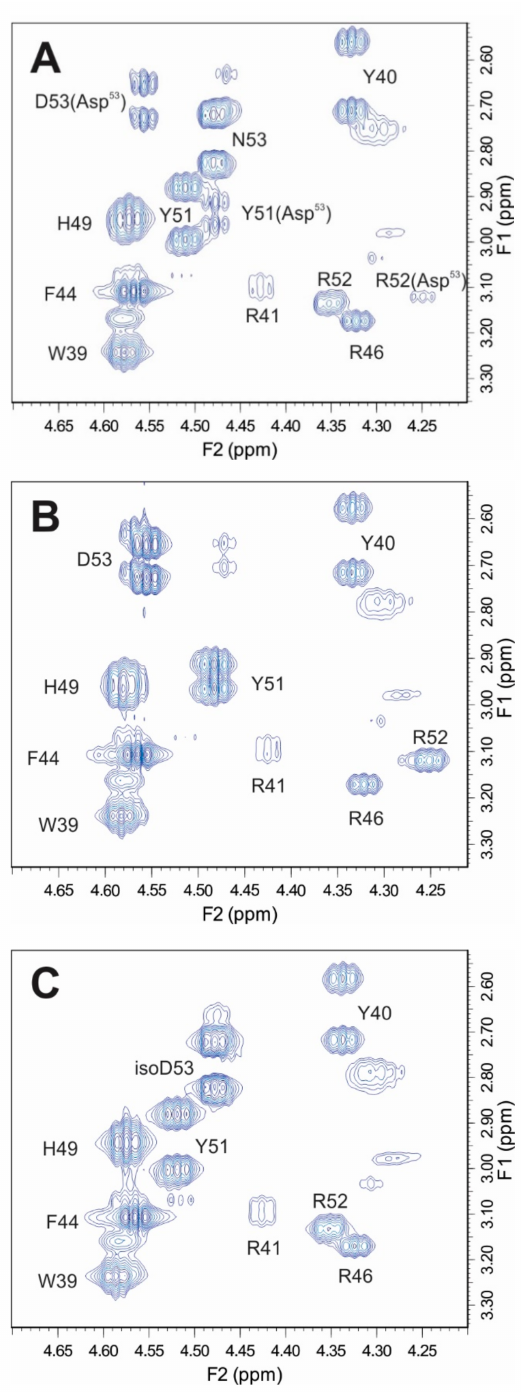
Figure 2. Expanded regions of Total Correlated Spectroscopy (TOCSY) spectra of: ( A ) (KG) 5 MOG 35–55 (Pep 5), ( B ) (KG) 5 MOG 35–55 (Asp 53 ) (Pep 6) and ( C ) (KG) 5 MOG 35–55 (isoAsp 53 ) (Pep 7) recorded in bicarbonate bu ff er, pH